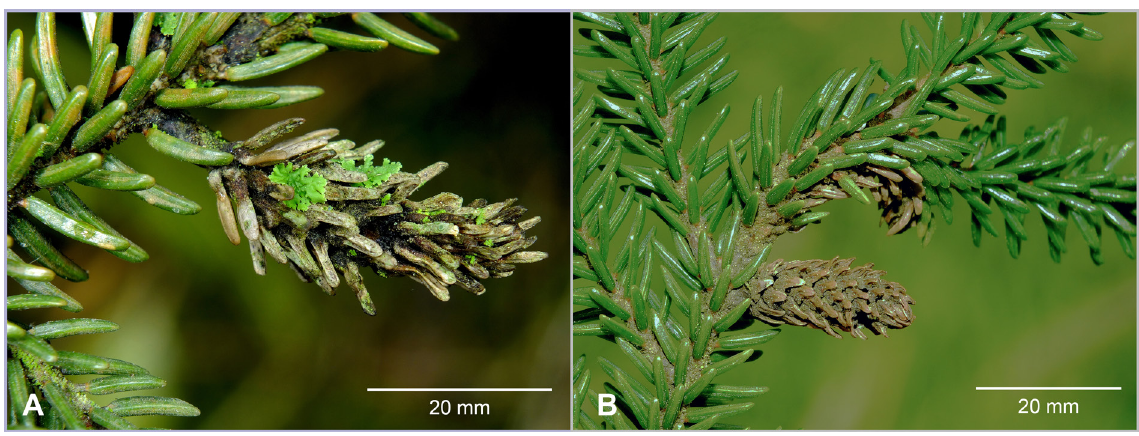
Fig. 3. Pineus (Pineus) orientalis (Dreyfus, 1889), old galls on Picea orientalis .